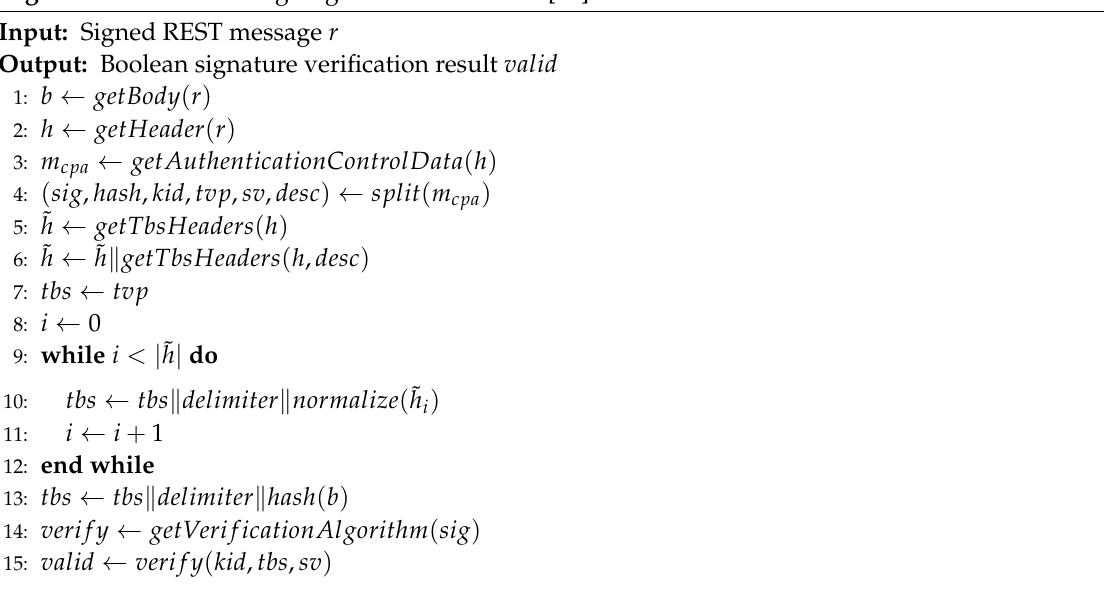
Algorithm 2 REST message signature verification [28].